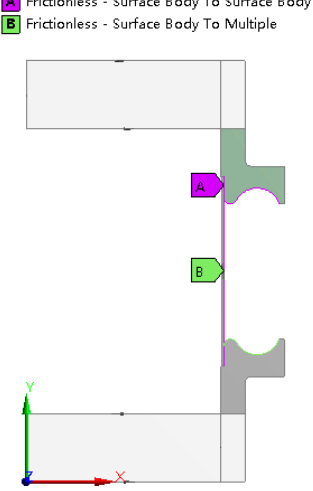
Figure 5. Illustration of frictionless contact positions.